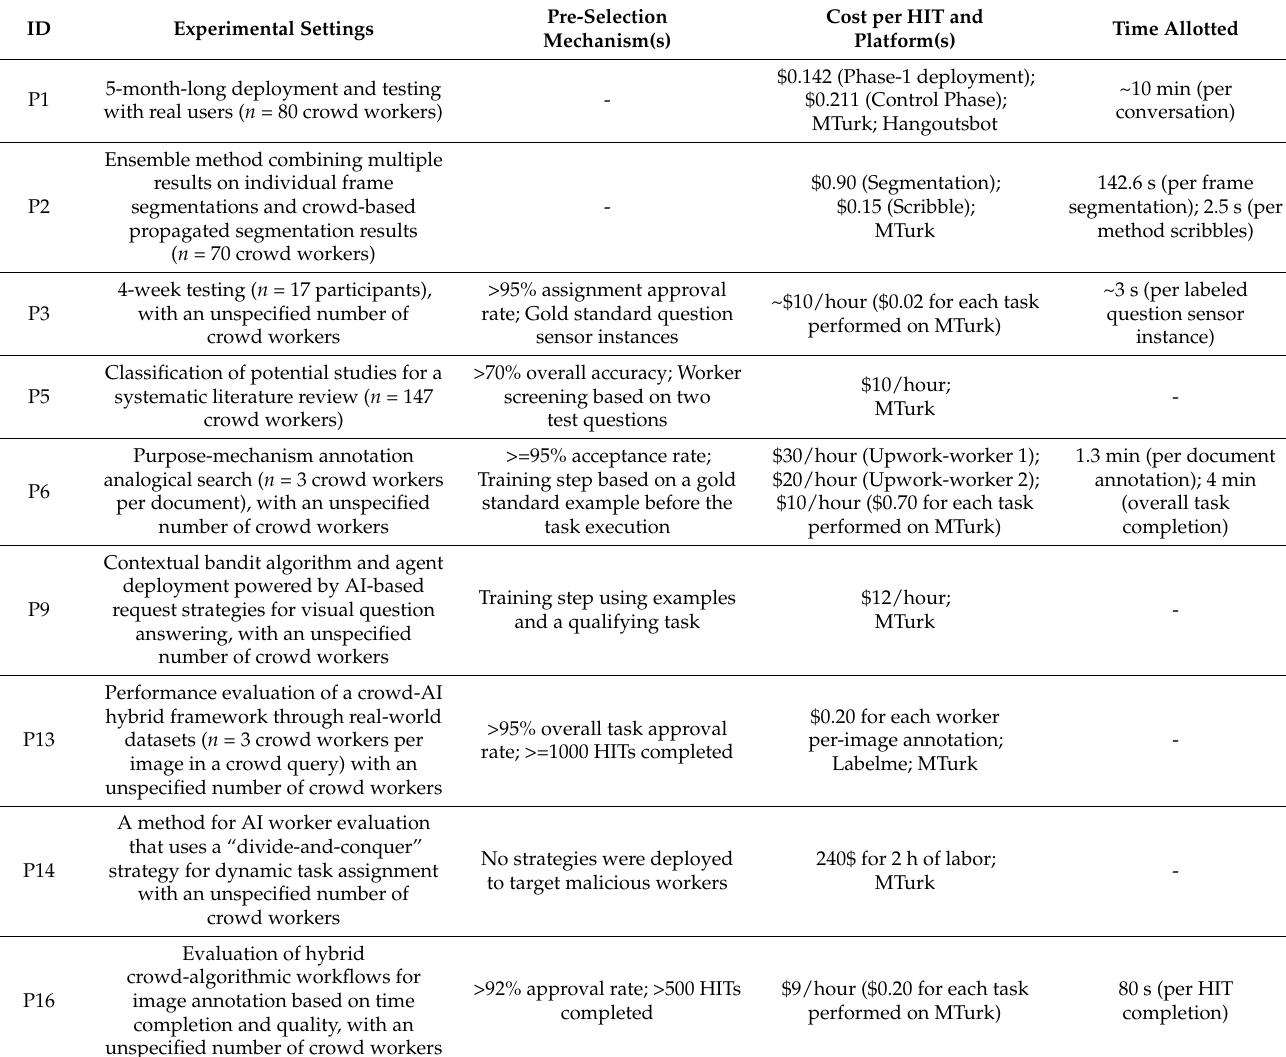
Table 1. Methodological remarks extracted from primary studies reporting paid crowdsourcing experiments conducted